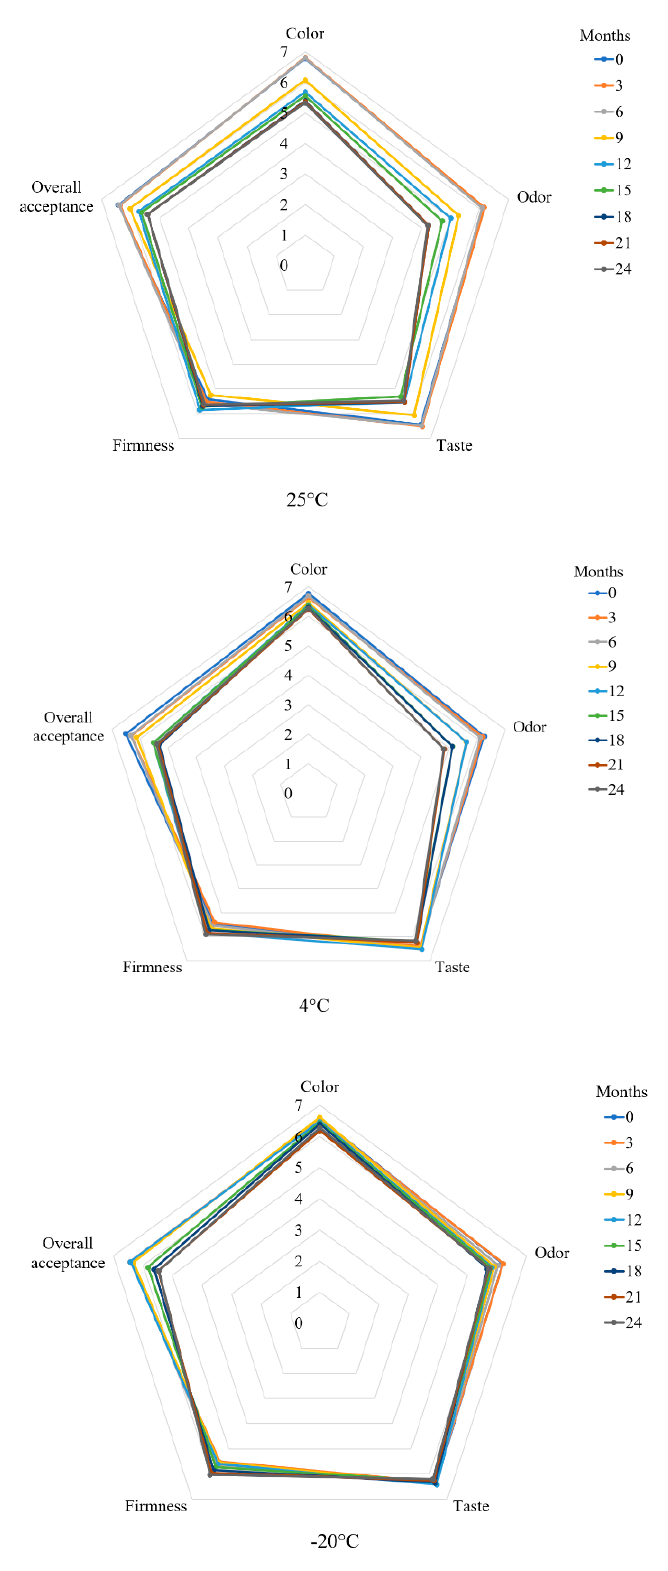
Figure 4. Sensory evaluation of wheat noodles fortified with isomaltodextrin during different storage periods at 25, 4, and − 20 ◦ C.